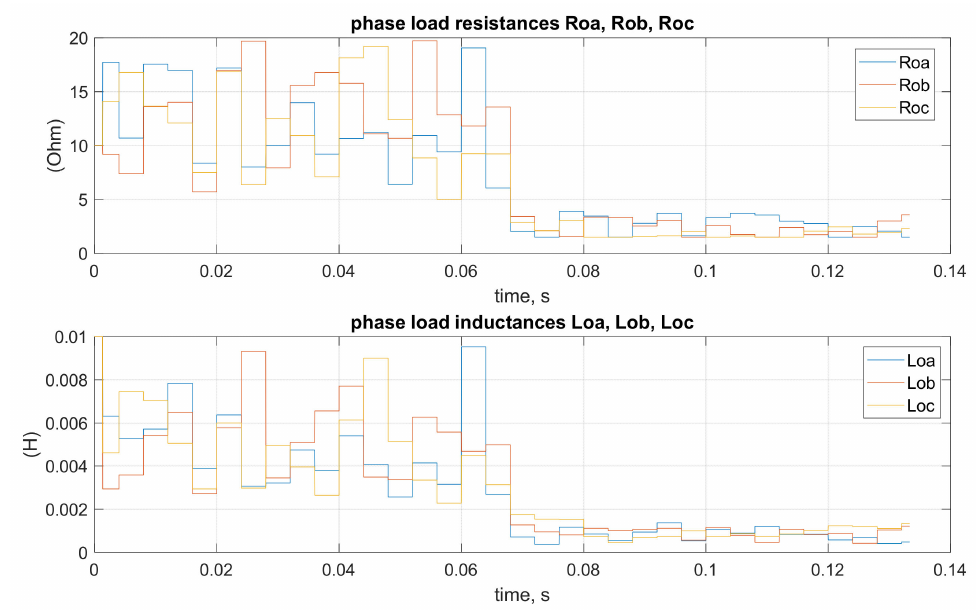
Figure 19. Waveforms of load phase resistances and inductances simulating a steep load